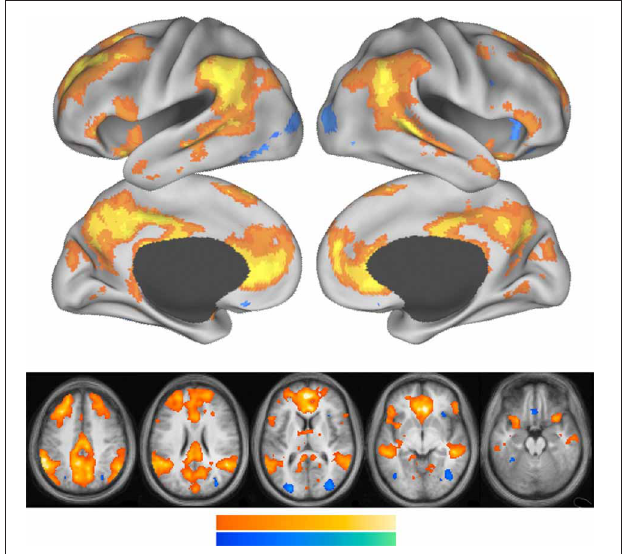
FIGURE 3 | This figure is from Andrews-Hanna et al. (2010). Whole-brain exploratory analyses were conducted using the main effect contrast of self trials vs. non-self control trials. Warm colors represent greater activation during self trials, whereas cool colors represent greater activation during non-self control trials. Increased activation during self trials was observed prominently in the PCC and the MPFC and temporal parietal